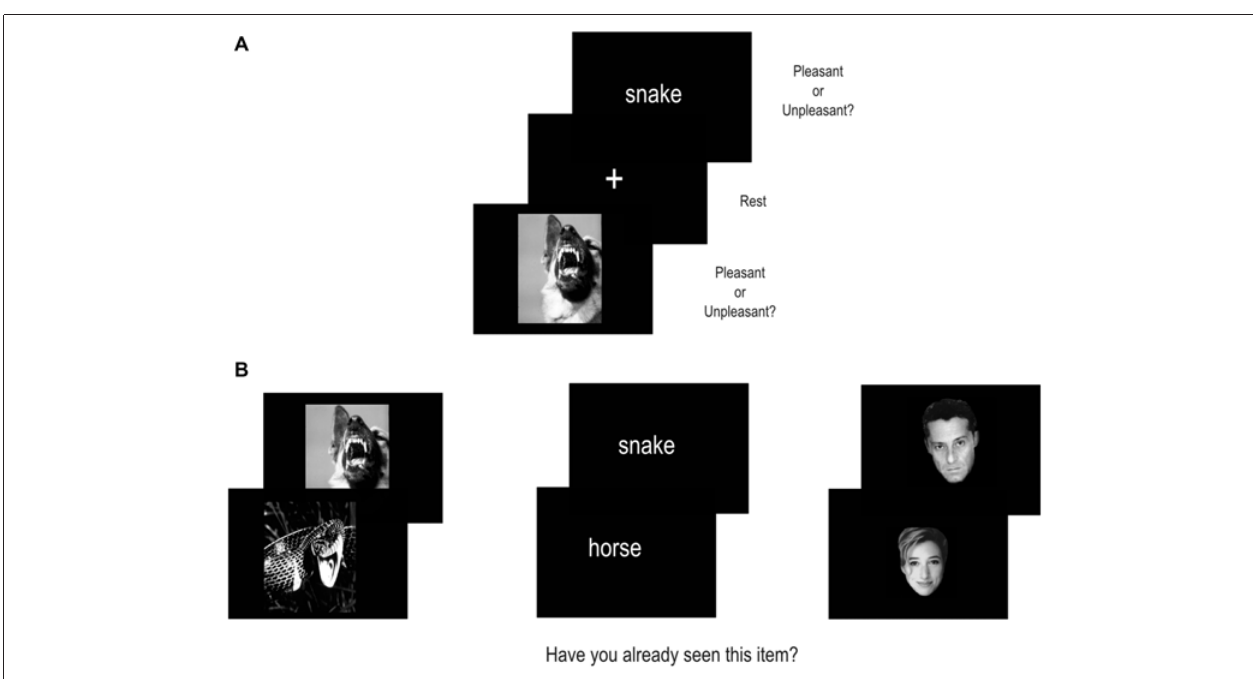
FIGURE 1 | Illustration of the experimental procedure. (A) shows the encoding task performed inside the MR scanner. (B) shows the recognition task performed outside the MR scanner.